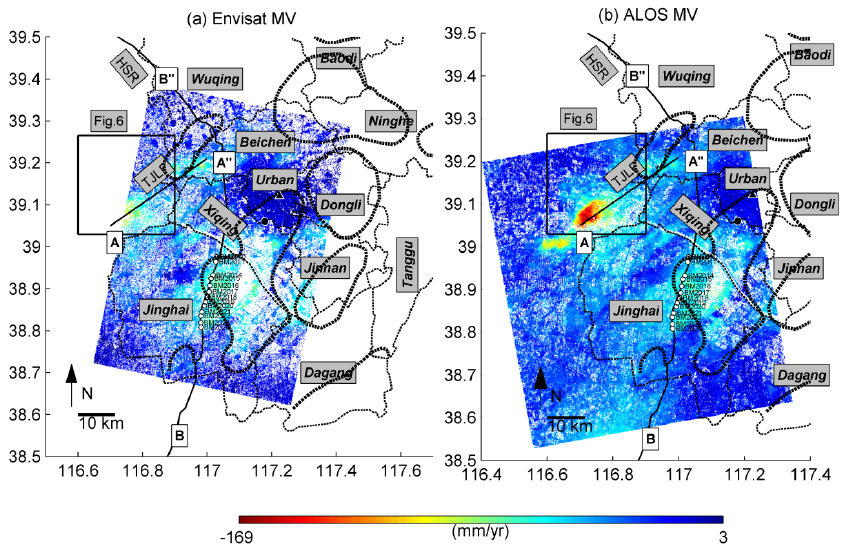
Figure 2. LOS (line of sight) rates from ALOS (17 January 2007 to 9 September 2009) and Envisat (4 January 2008 to 12 June 2009) satellites. Negative values mean moving away from the satellite (e.g., subsidence). The straight line “TJLF (Tianjin Langfang)” is located between Tianjin City and Langfang City. The poly line “HSR (High Speed Railway)” is the path of Jing-Hu high speed railway. The displacement rates along the two swathes are shown in Figure 3. BM2010 and BM2011, along with other benchmarks, are shown in white dots. Leveling results for all benchmarks are compared with InSAR displacements in Figure 4. Reference points for InSAR and leveling are shown in black triangle and dot respectively. Model area is outlined by rectangle. Counties and districts in Tianjin are outlined by thin dashed line. Geothermal fields with gradient above 3.5 (°C/100 m) are outlined by thick dashed line.